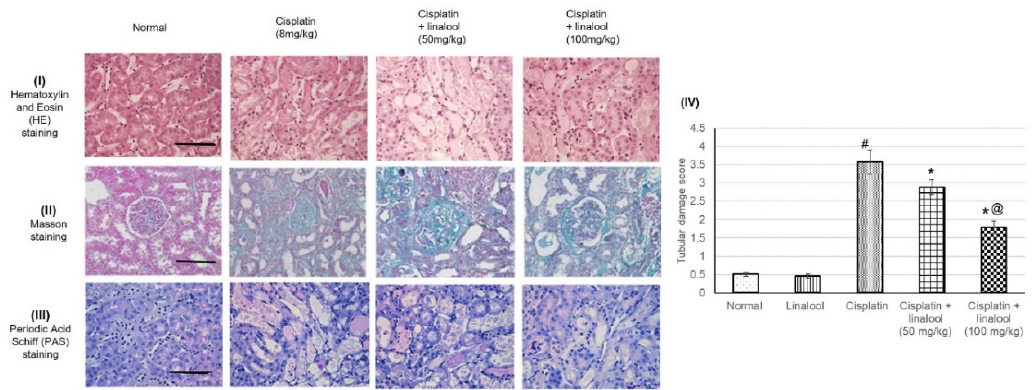
Figure 6. Histopathological analysis showing the protective effect of linalool (50 and 100 mg/kg) on the kidney tissues challenged through cisplatin injection: representative photomicrographs of ( Ⅰ ) hematoxylin and eosin (H&E) staining, ( Ⅱ ) Masson staining, and ( Ⅲ ) periodic acid Schiff (PAS) staining, and ( Ⅳ ) quantitative assessment of tubular damage score. All values are expressed as mean ± SD. # indicates statistically significant from the normal control group, * denotes statistically significant from the cisplatin-only group, @ indicates statistically significant from the cisplatin + linalool 50 mg/kg group ( p < 0.05) using one-way ANOVA followed by Tukey’s post-hoc test. Renal injury was scored based on the proportion of damaged tubules in the kidney sample where 0 = normal kidney (no damage), 1 = minimal damage (less than 25% damage), 2 = mild damage (25–50% damage), 3 = moderate damage (50–75% damage), and 4 = severe damage (> 75% damage).